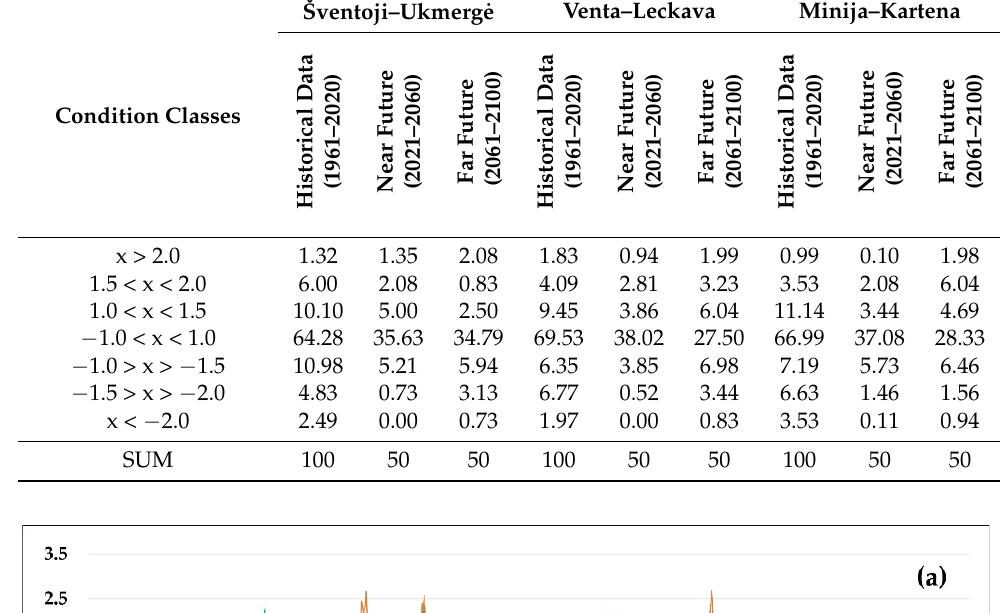
Table 10. Changes of SDI (x in Table) according to RCP 8.5.